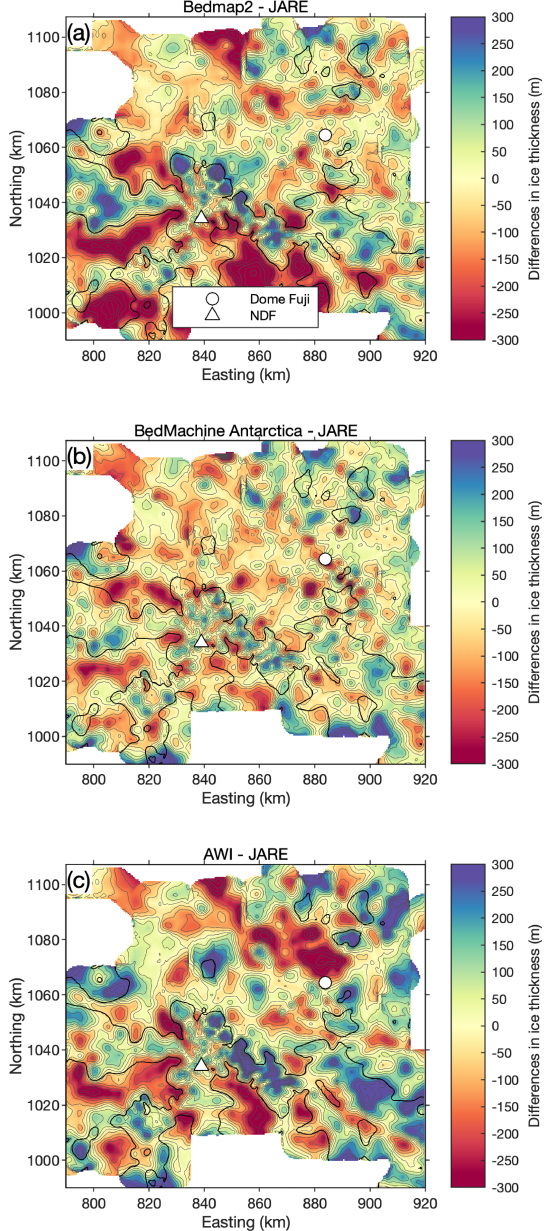
Figure 7. The differences in ice thickness between (a) Bedmap2, (b) BedMachine Antarctica v1 and (c) AWI ice thickness data and the gridded data generated in this study. The bold contours in all plots indicate an ice thickness of